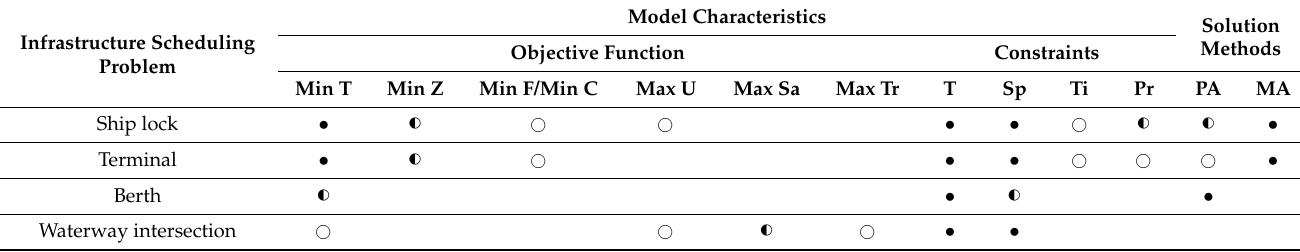
Table 8. Comparison of research on infrastructure scheduling problems.